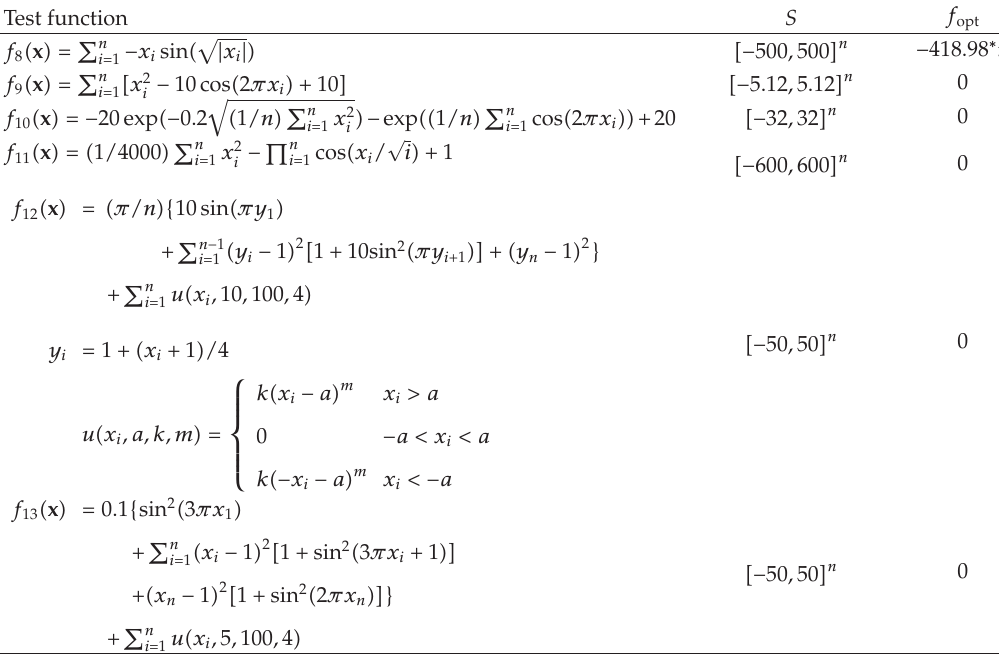
Table 13: Multimodal test